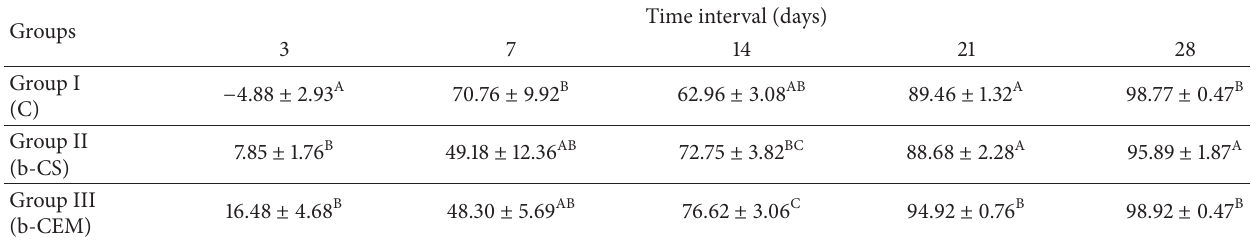
Table 2: Mean ± SE of percent contraction of wound (%) at different time intervals in various groups. Groups